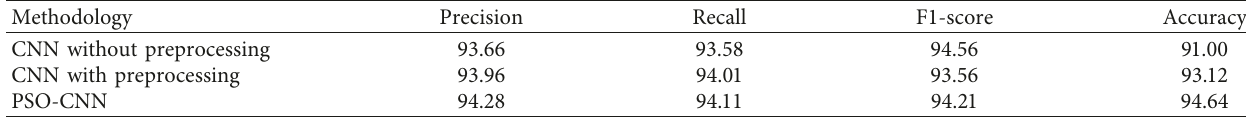
Table 4: A comparative analysis of proposed method before data augmentation process.